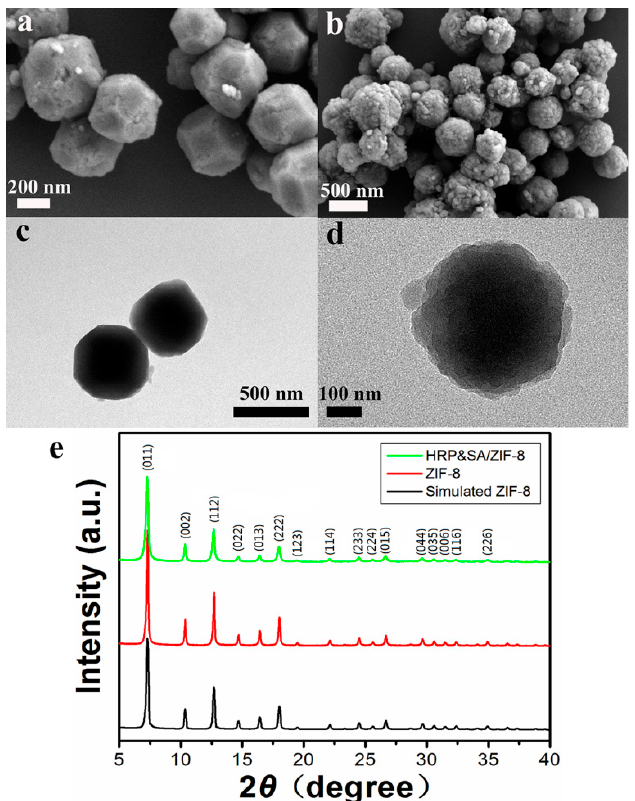
Figure 1. ( a ) SEM image of ZIF-8; ( b ) SEM image of HRP&SA/ZIF-8 nanocomposites; ( c ) TEM image of ZIF-8; ( d ) TEM image of HRP&SA/ZIF-8 nanocomposites; ( e ) XRD pattern of HRP&SA/ZIF-8 nanocomposites.